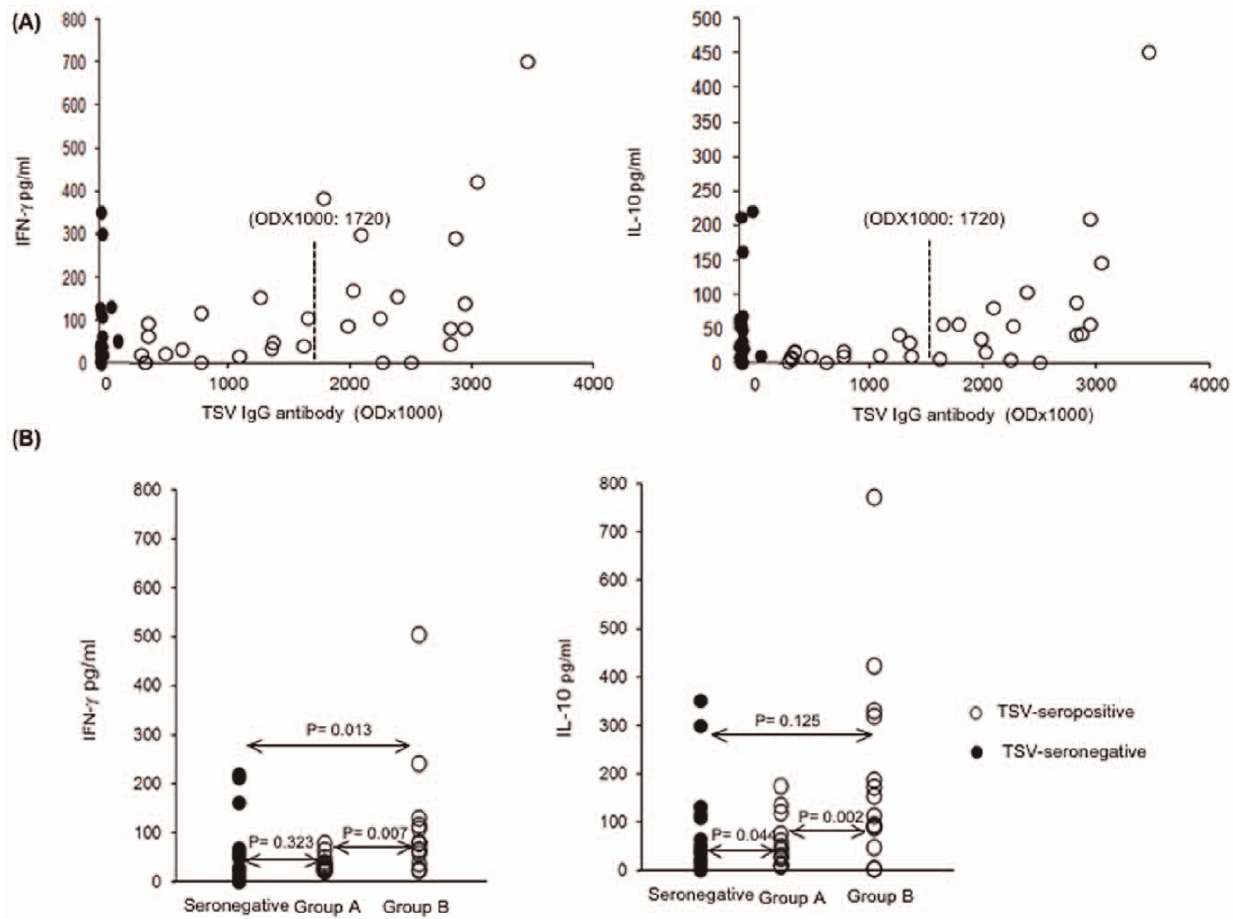
Figure 5. (A) Effect of TSV-specific IgG level on Th-cell responses. TSV-specific IFN- c and IL-10 responses were plotted against TSV-IgG among seropositive (open circles) and seronegative individuals (closed circles). TSV VP1 specific humoral immune response is shown by optical density 6 1000 (OD 6 1000). Median OD 6 1000 (1720) is shown by (–) a line. ( B ) TSV-specific IFN- c and IL-10 responses were compared between the TSV- seronegative subjects and sub-groups of TSV-seropositive subjects. Group A: TSV-seropositive subjects having TSV-IgG OD 6 1000 below 1720, and group B: subjects having TSV-IgG OD 6 1000 above 1720.